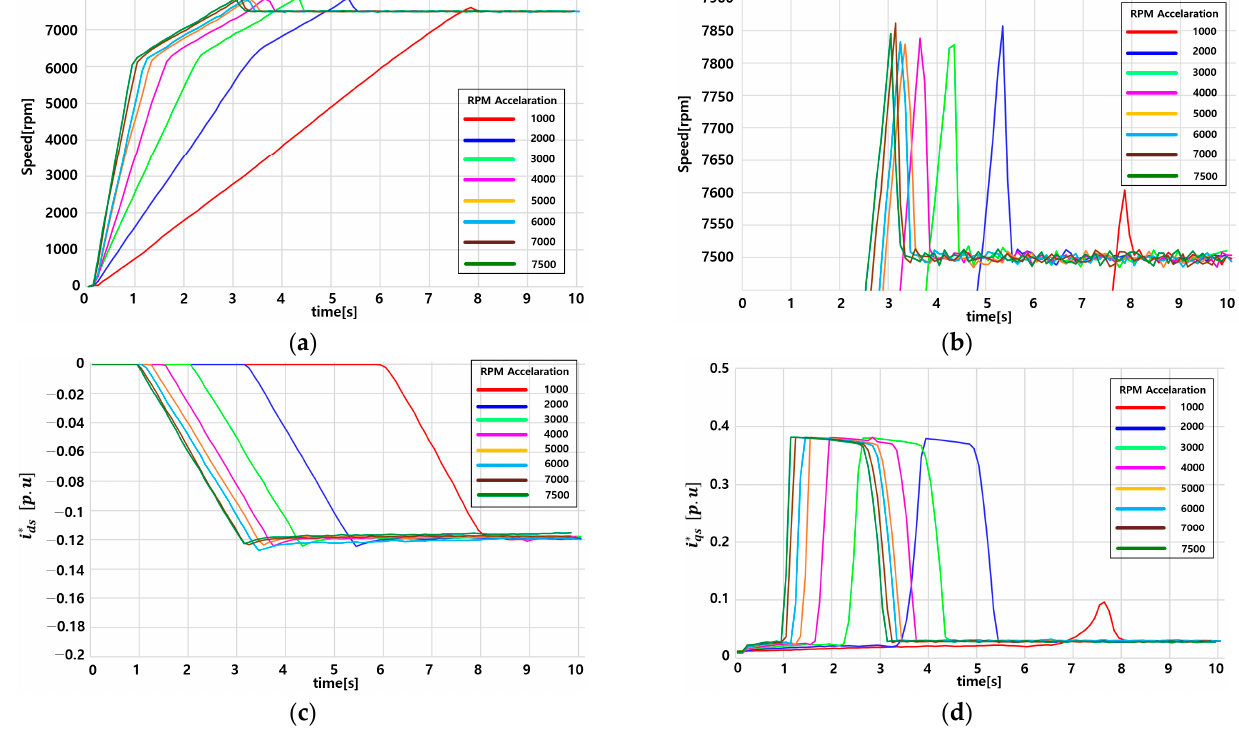
Figure 10. Experimental results when ∆ i ∗ is 5.34 × 10 − 5 : ( a ) motor speed; ( b ) motor speed; ( c ) d-axis current; ( d ) q-axis